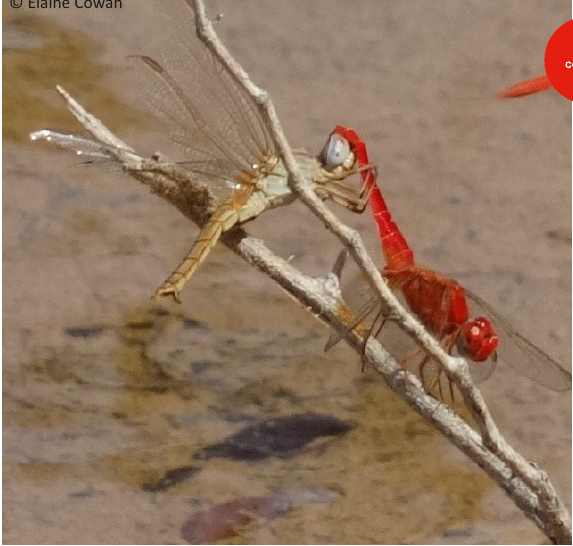
Image 20. Crocothemis erythraea pair separating from mating wheel, 5 June 2014. Note vulvar scale near tip of female’s abdomen (also visible in Image 19).